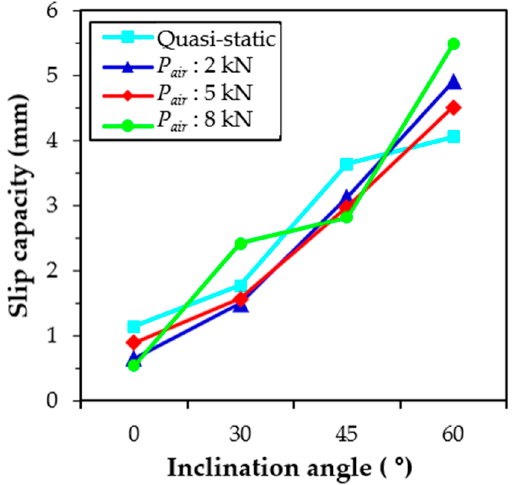
Figure 7. Effects of loading rate and inclination angle on slip capacity of S-fibers (Note: P air = air